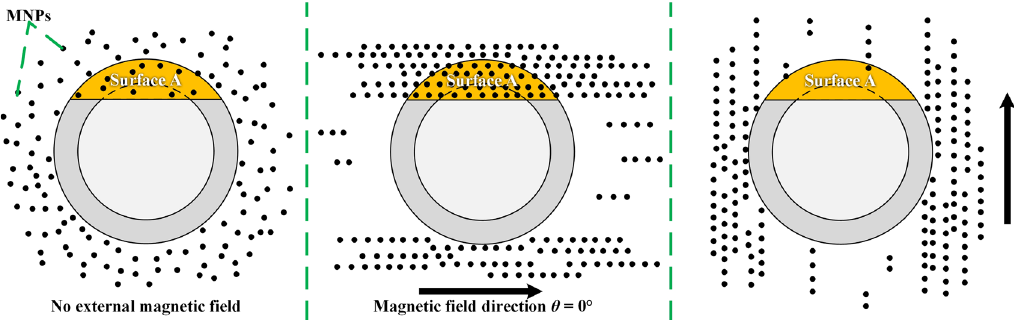
Figure 3: Distribution of MNPs under different magnetic field direction.